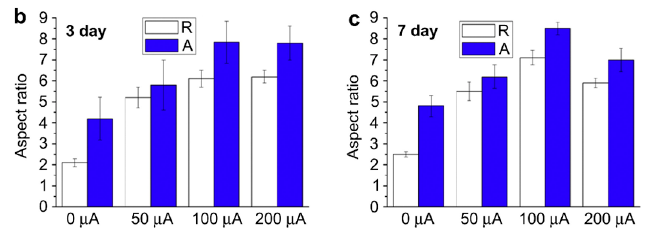
Figure 5. Scanning electron microscopy images of osteoblasts cultured on random (R) and aligned (A) nanofiber meshes of PLA/multi-walled carbon nanotubes (MWCNT)-ox 3 wt % produced by solution mixing followed by electrospinning, without or with electrical stimulation 0-200 µA ( a ); Osteoblast elongation is presented as the aspect ratio ( b , c ). Scale bars represent 30 µm [191].